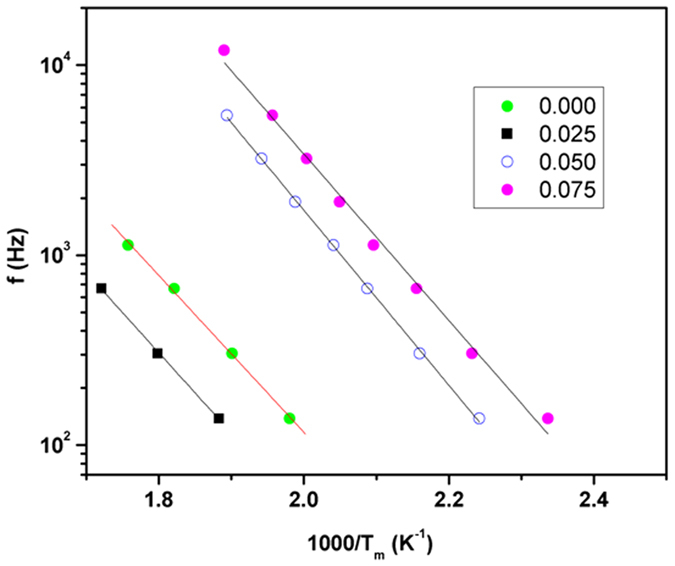
Variation of peak maxima of relaxation peak (Tm) with frequency for cubic SrTi1−2xFexTaxO3 compositions (x = 0.0, 0.025, 0.050 and 0.075) compositions.Solid lines are fits to the Arrhenius relation.